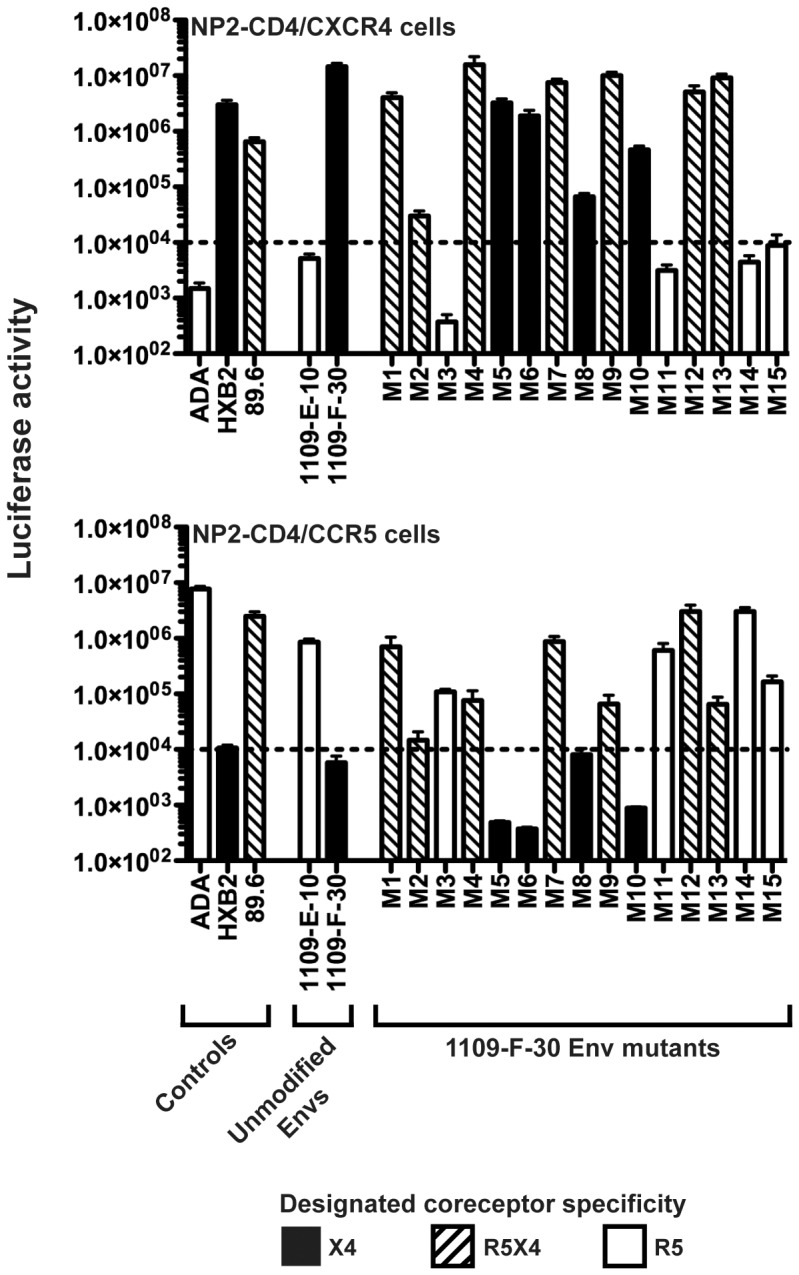
V3 loop alterations important for CXCR4 usage by C-HIV harbored by subject 1109.Luciferase reporter viruses pseudotyped with Env mutants (M1 through M15), unmodified 1109-E-10 and 1109-F-30 Envs, or control Envs (ADA, HXB2, 89.6) were used to infect NP2-CD4/CXCR4 and NP2-CD4/CCR5 cells, and the levels of HIV-1 entry were determined as described in Materials and Methods. Open bars indicate Envs with an R5 phenotype, black bars indicate Envs with an X4 phenotype, and hatched bars indicate Envs with an R5X4 phenotype. The dotted lines indicate the limit of detection of coreceptor activity. The results shown are a compilation of 3 independent experiments, each performed in triplicate, and each with an independent preparation of Env-pseudotyped virus. The data shown are means, and the error bars represent standard errors of the means.